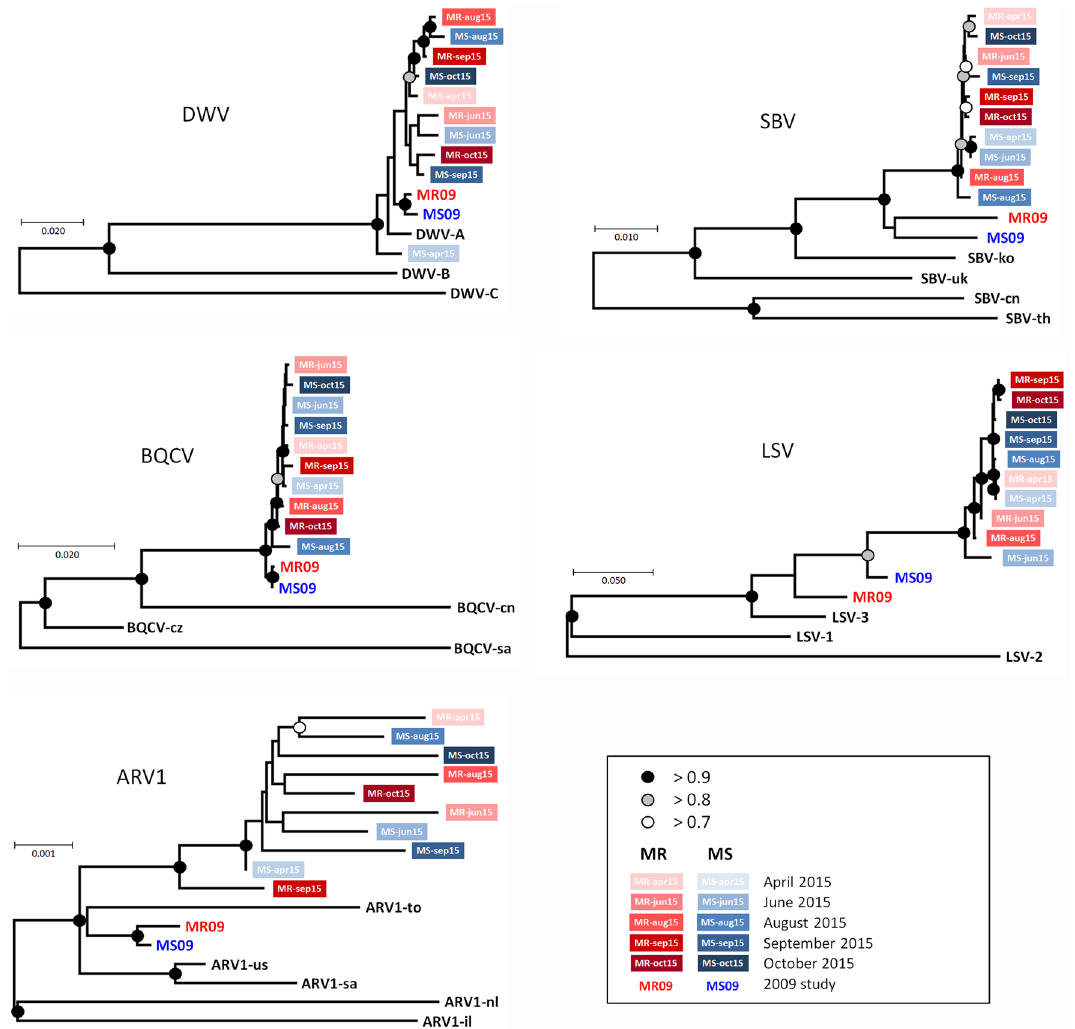
Figure 5. Phylogenetic analyses viral genomes. Phylogenetic analyses of the DWV, SBV, BQCV, LSV and ARV-1 consensus sequences for the MR colonies (red) and MS colonies (blue) from April to October 2015, with the seasonal sequences represented by increasingly darker shades of